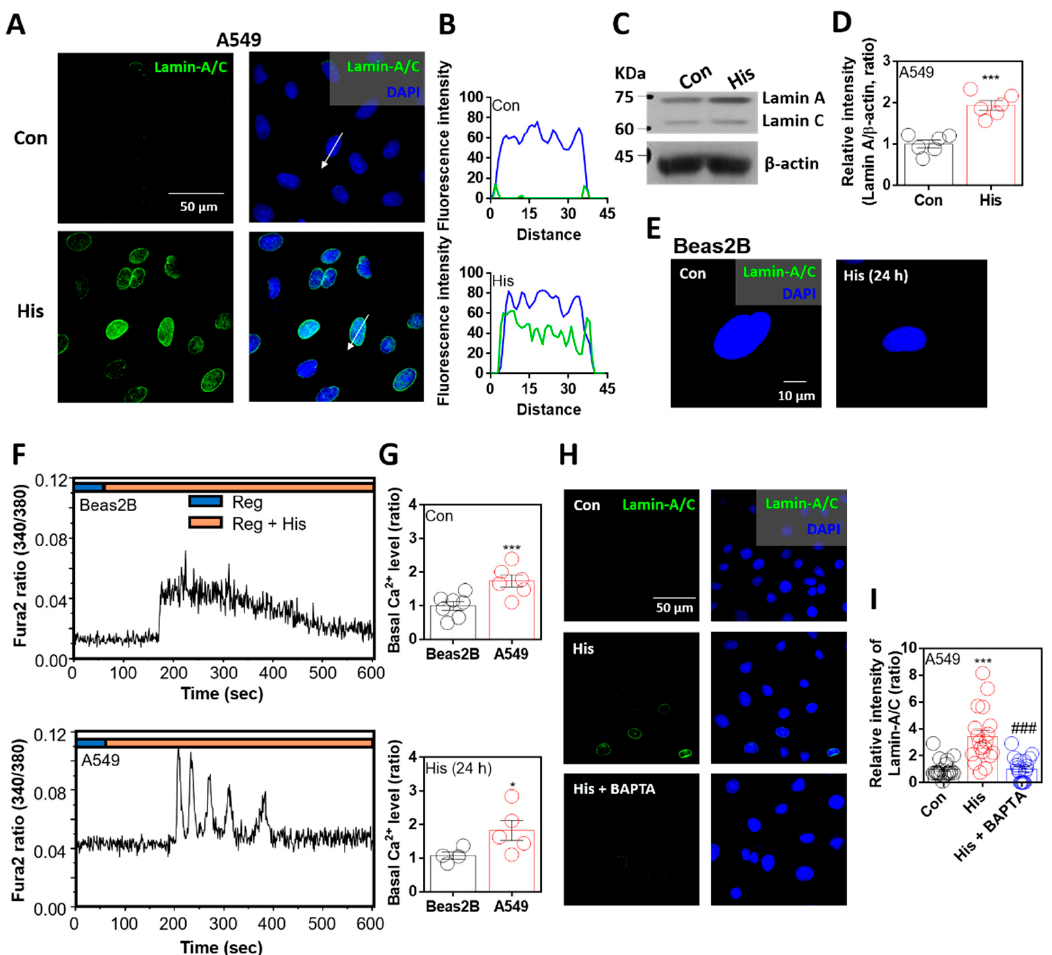
Figure 1. Lamin ‐ A/C expression was attenuated by intracellular calcium chelation. ( A ) Immunoflu ‐ orescence staining of lamin ‐ A/C (green) and DAPI (blue) after histamine (His) treatment (100 μ M, 24 h) in A549 cells. Scale bar represents 50 μ m. Right panels were merged images. ( B ) Fluorescence intensity in the sectional distance of cells indicated by white arrows. Green and blue lines indicated lamin ‐ A/C and DAPI, respectively. ( C ) Protein expression levels of lamin ‐ A/C after histamine treat ‐ ment (100 μ M, 24 h) in A549 cells. ( D ) The graph indicates relative intensity of lamin ‐ A. β‐ actin was used as a loading control. The bars represent the mean ± SEM ( n = 6, *** p < 0.001). ( E ) Immunofluo ‐ rescence staining of lamin ‐ A/C (green) and DAPI (blue) after histamine treatment (100 μ M, 24 h) in Beas2B cells. Scale bar represents 10 μ m. Left panel was merged image. ( F ) Changes in intracellular Ca 2+ concentration in response to histamine treatment (100 μ M) in Beas2B (upper panel) and A549 (lower panel) cells. Top bars indicate the stimulated extracellular solutions. ( G ) Basal calcium levels of Beas2B and A549 cells after histamine treatment (100 μ M, 24 h). The bars represent the mean ± SEM ( n = 4 ~ 7, * p < 0.05, *** p < 0.001). ( H ) Immunofluorescence staining of lamin ‐ A/C (green) and DAPI (blue) after histamine treatment (100 μ M, 24 h) with and without BAPTA ‐ AM (BAPTA; 10 μ M, 24 h) in A549 cells. Scale bar represents 50 μ m. Right panels were merged images. ( I ) The graph indicates relative intensity of lamin ‐ A/C. The bars present the mean ± SEM ( n = 19 ~ 20, *** p < 0.001 vs. control and ### p < 0.001 vs. His ‐ treated group). Schemes follow the same formatting.